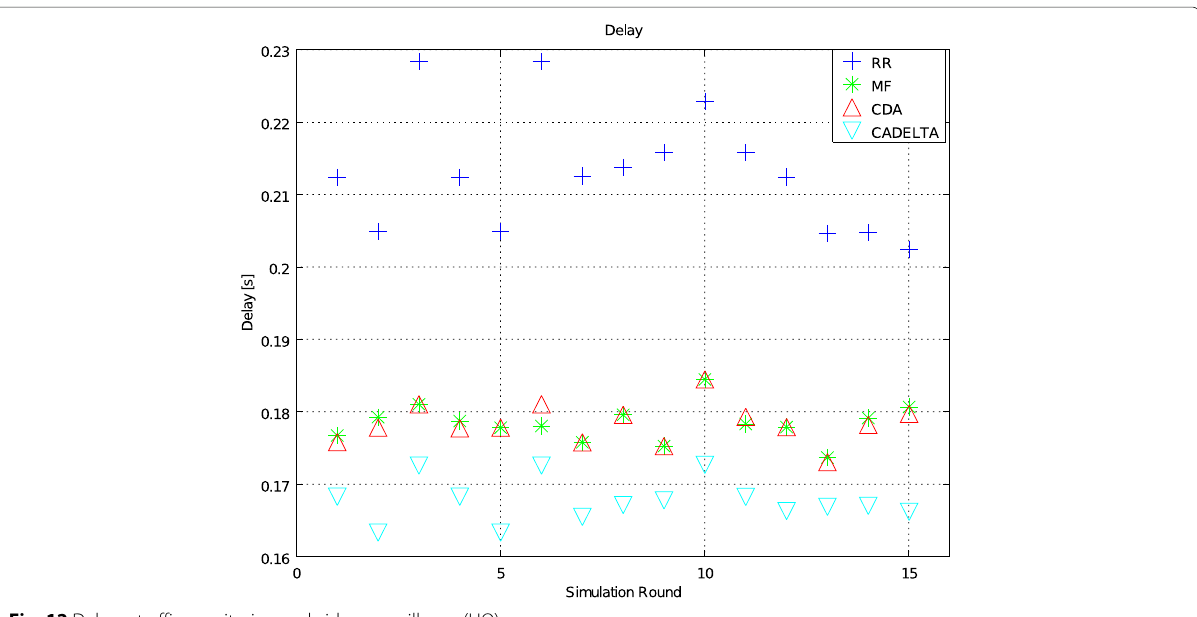
Fig. 12 Delay—traffic monitoring and video surveillance